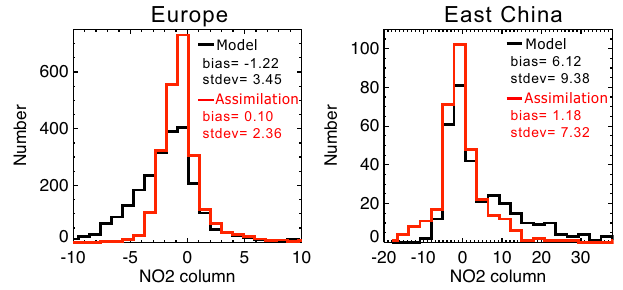
Fig. 10. Observation minus forecast (OmF) distributions of tro- pospheric NO 2 columns (in 10 15 molec . cm − 2 ) calculated from the model simulation (black line) and the data assimilation run (red line) over Europe (10 ◦ W–30 ◦ E, 35–60 ◦ N, left panel) and eastern China (110–123 ◦ E, 30–44 ◦ N, right panel) for the period 16–30 January 2005. The numbers shown in the figures are the mean value (bias) and the standard deviation (stdev) of the OmF in 10 15 molec . cm − 2 for the model simulation (black) and for the assimilation run (red).